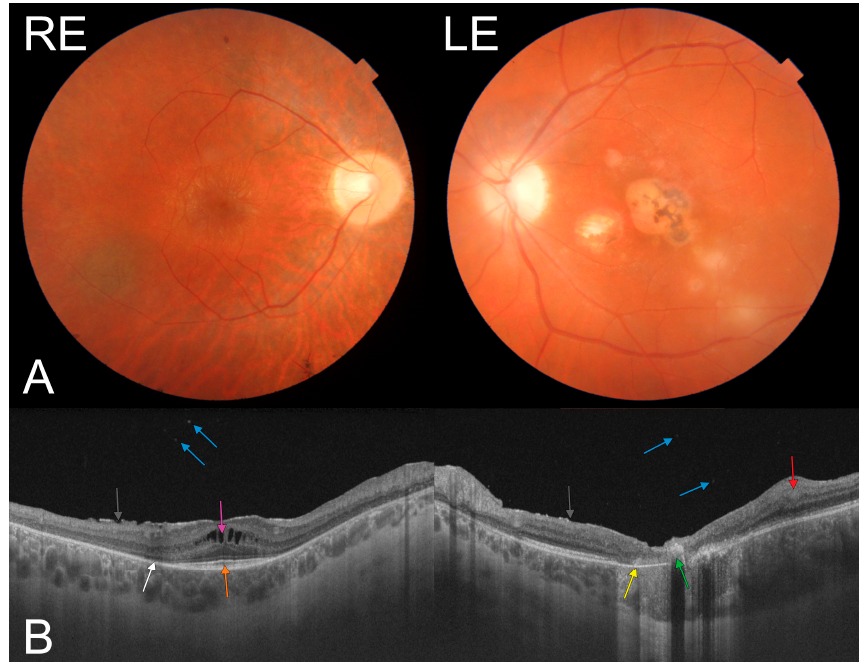
Figure 2. ( A ) Color fundus photography of the posterior pole showing an epiretinal membrane in the macula in the right eye (RE), as well as active inflammatory lesions at the border of the pre-existing chorioretinal scar in the macula of the left eye (LE). ( B ) Swept-source optical coherence tomography showing cystoid macular edema (pink arrow) with an epiretinal membrane (black arrow), a normal RPE and foveal photoreceptors (orange arrow) but no photoreceptor–pigment epithelium complex (white arrow) in the rest of the retina, single hyperreflective satellite spots in the vitreous of the RE (blue arrow), and atrophy of the outer retinal layers in the fovea (yellow arrow), with a hyperreflective area corresponding to pigment deposits (green arrow), and retinal thickening and disorganization of the retinal structure (red arrow) with markedly thickened choroid corresponding to an active inflammatory lesion with hyperreflective satellite spots in the vitreous (blue arrow) in the LE.